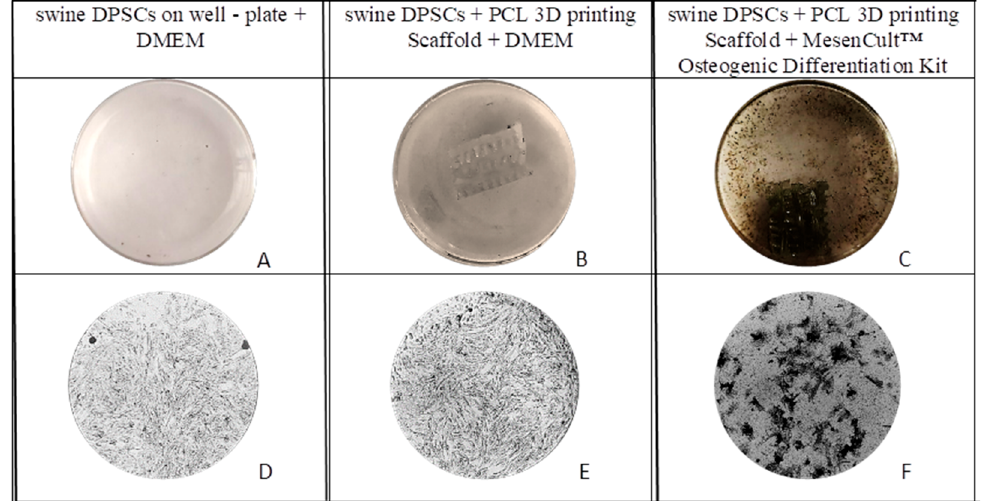
Figure 6. Representative images of the mineral deposition of swine Dental Pulp Stem Cells (DPSCs) on day 28 by von Kossa staining (top) ( A – C ), and respective microscopy images ( D – F ) at the bottom, 10×.